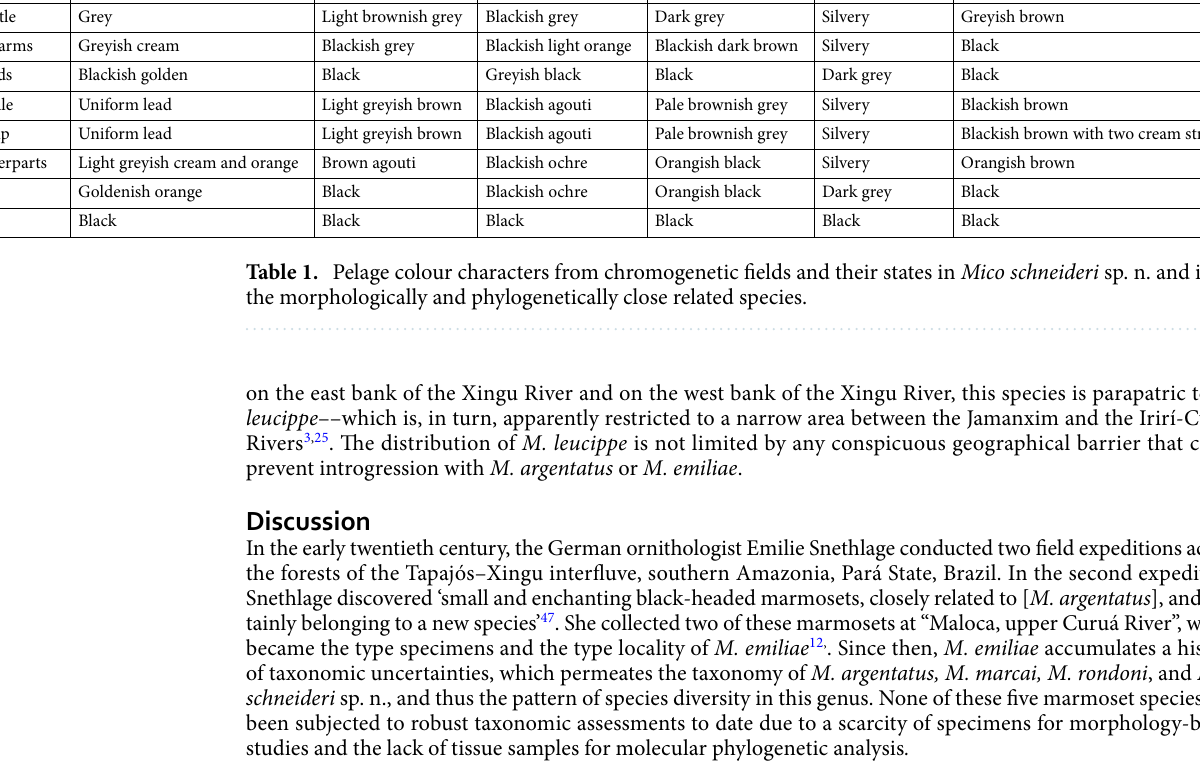
Mico schneideri sp. n